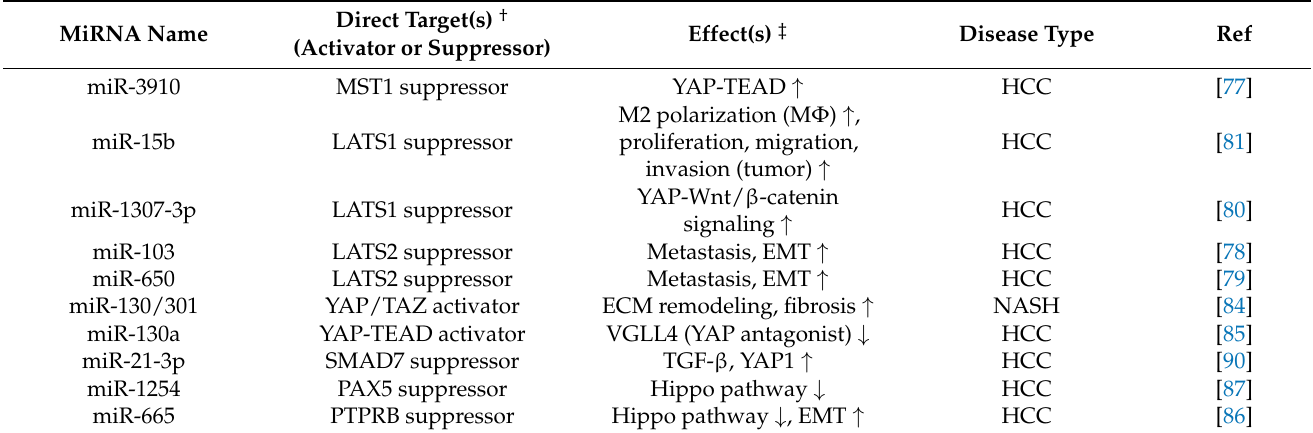
Table 2. List of oncogenic microRNAs activating YAP/TAZ and their effect(s) on liver